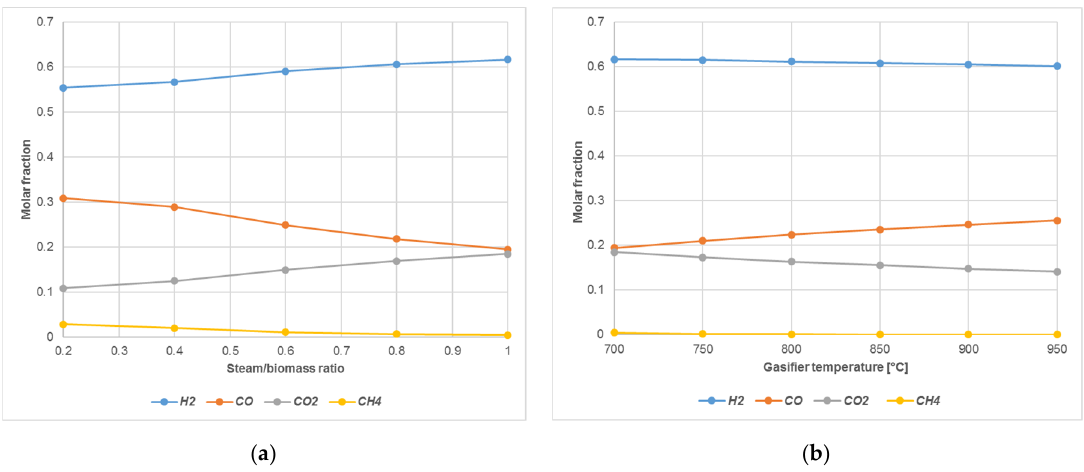
Figure 12. ( a ) Effect of steam/biomass ratio and gasifier temperature on the water free composition of the produced syngas; ( b ) effect of gasifier temperature on the water free composition of the produced syngas.